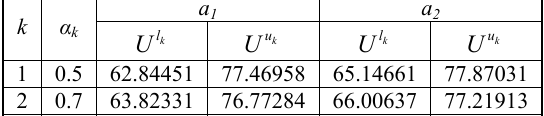
Fig. 12. Global fuzzy belief degrees of a 1 under